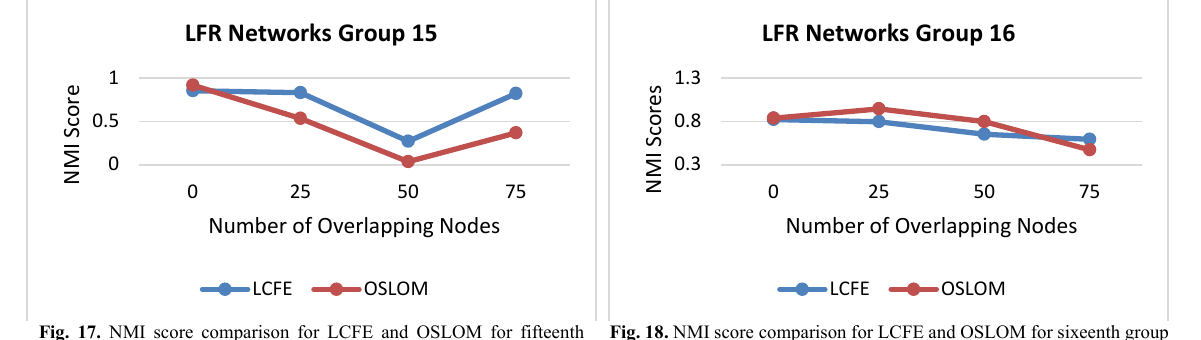
Fig. 18. NMI score comparison for LCFE and OSLOM for sixeenth group of LFR Networks with number of overlapping nodes ranging from 0 to 75